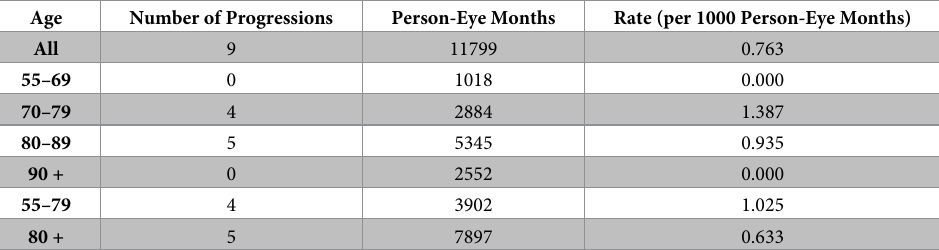
Table 2. Rates of progression by age.